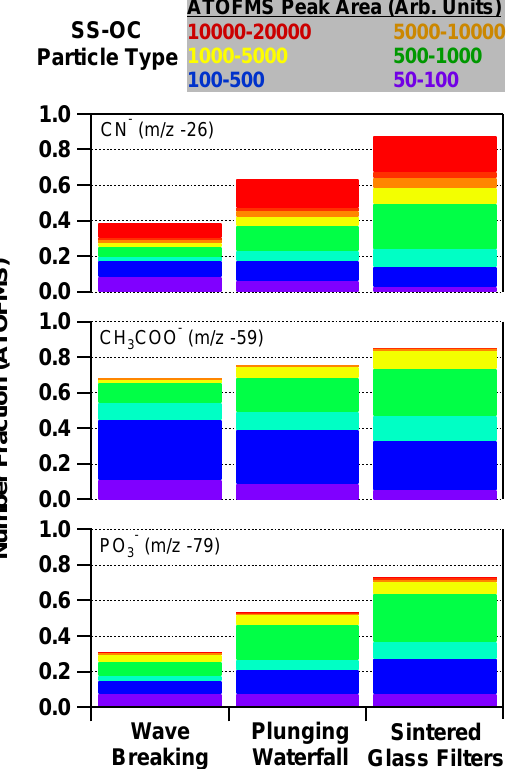
Figure 5. Color-stack plots showing ATOFMS ion markers for or- ganic nitrogen (CN − ) , oxygenated organic carbon (CH 3 COO − ) , ) , considering only particles composed of an and phosphate (PO − 3 internal mixture of sea salt and organic compounds (SS-OC) all sizes. The vertical axis indicates the number fraction of SS-OC particles whose mass spectrum includes each marker, with the color indicating the peak area of the marker. Notice that, from left to right, a larger fraction of SS-OC particles contain these or- ganic/biomolecule marker ions; the peak area also increases, sug- gesting that each particle contains more of each chemical species moving from left to